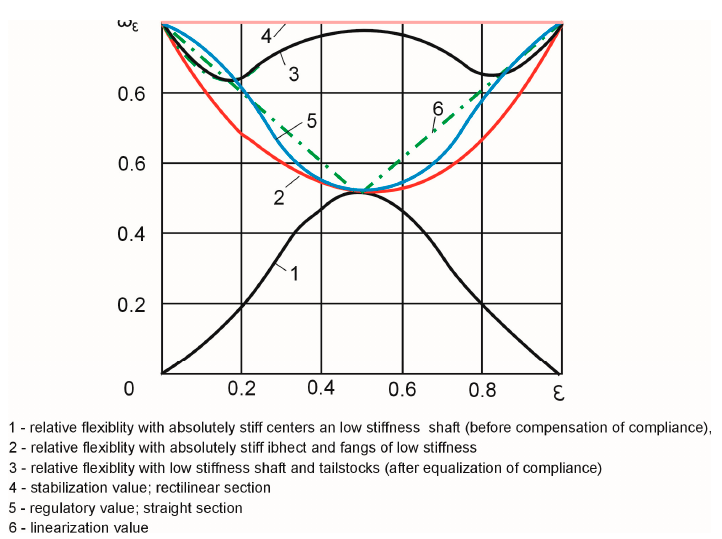
Figure 2. Relative compliance of elastic technological systems depending on the length of machining ϖ ε = f( ε ) [10].